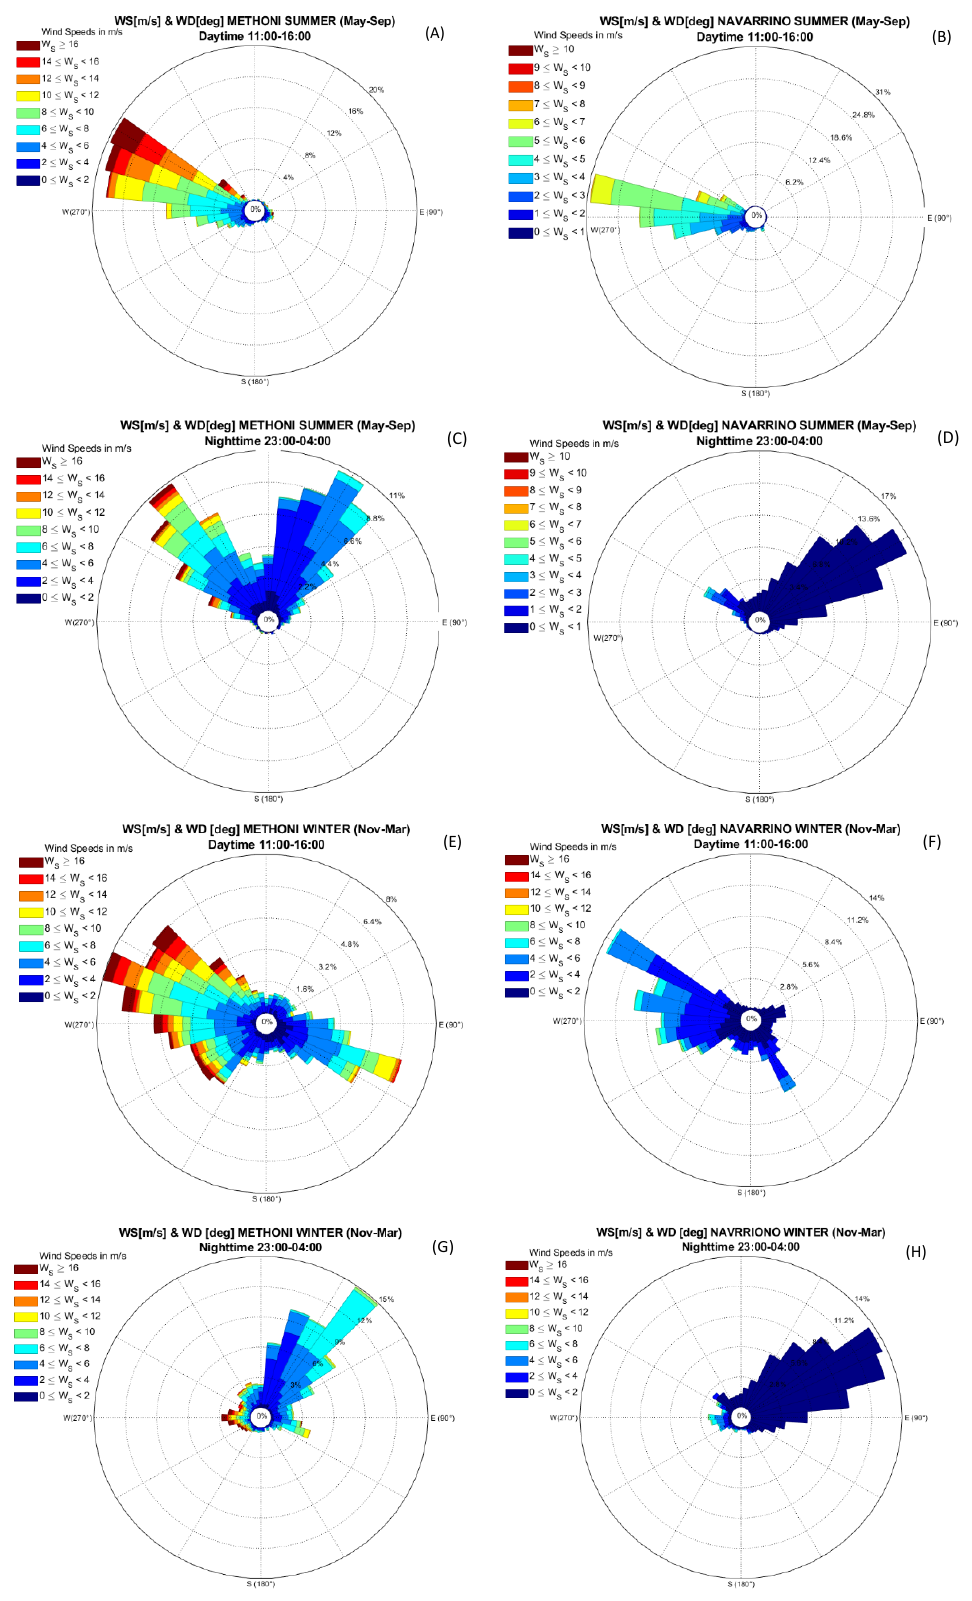
Figure 4. Local wind roses for Methoni ( A , C , E , G ) and Navarino ( B , D , F , H ). The warm season daytime is on the top row while night time is 2nd row. The wind roses for the cold season daytime is 3rd while nighttime is on the 4th row.